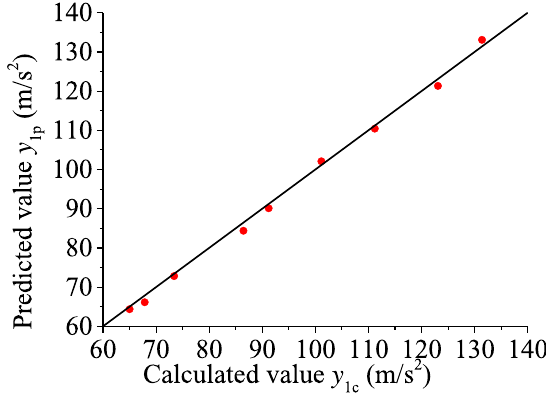
Fig. 17. Veri fi cation of Kriging surrogate model y 1